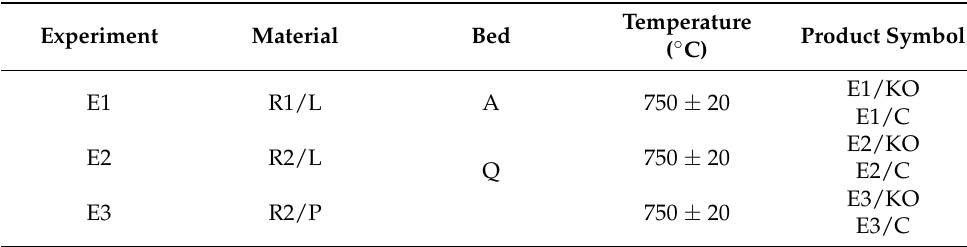
Table 1. Experimental conditions for the combustion of poultry manure in the laboratory fluidised bed reactor and list of the symbols